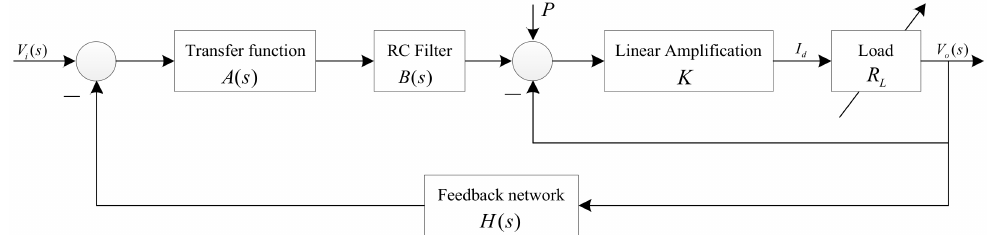
Figure 7. The control block diagram of the circuit mentioned in the